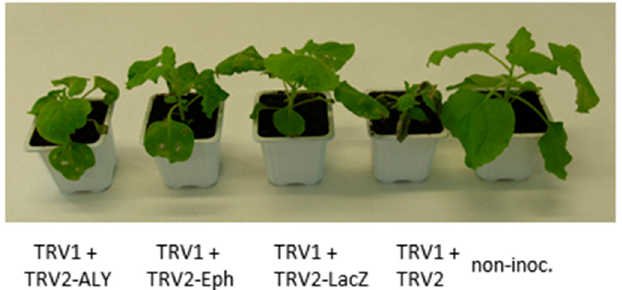
Figure 4. Development of N. benthamiana infected with recombinant Tobacco rattle virus